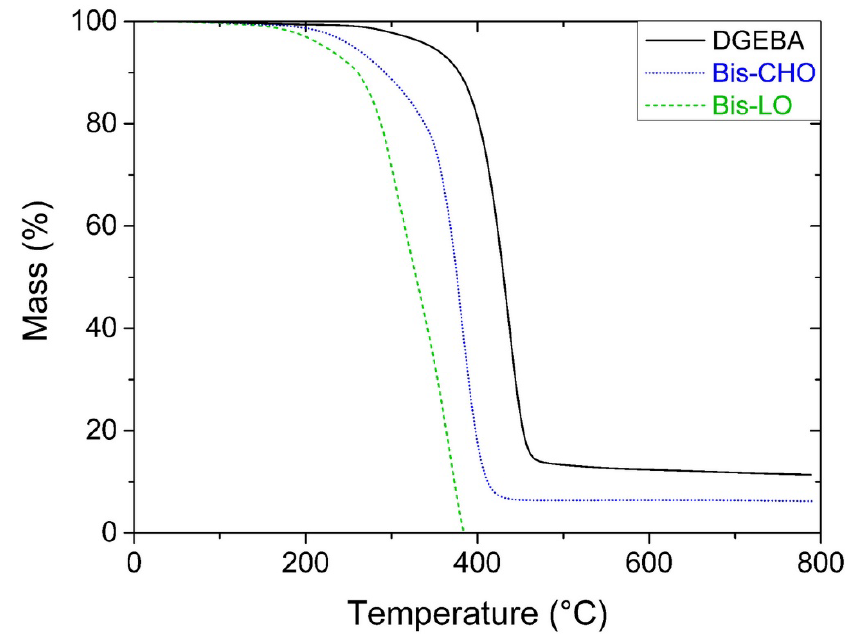
Figure 7. TGA thermograms of DGEBA, bis-CHO and bis-LO based networks with HMPA.